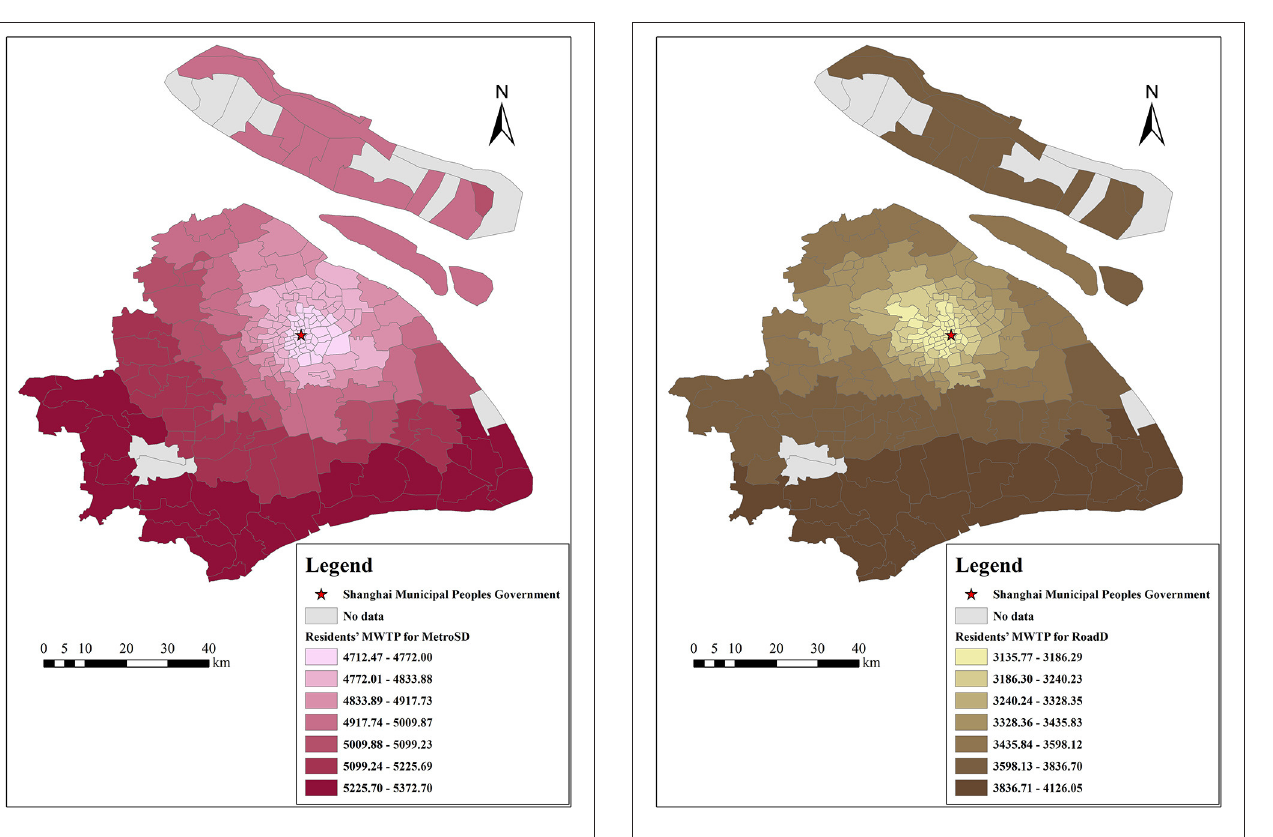
FIGURE 12 | The spatial heterogeneity of MWTP for metro station density. FIGURE 13 | The spatial heterogeneity of MWTP for road network